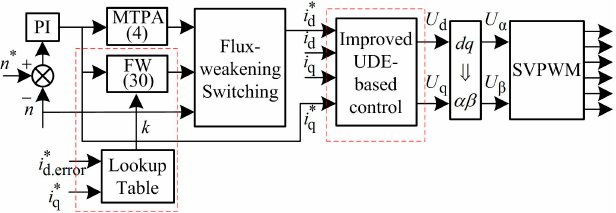
Figure 6. The improved UDE-based control strategy for interior permanent magnet synchronous motors (IPMSMs).